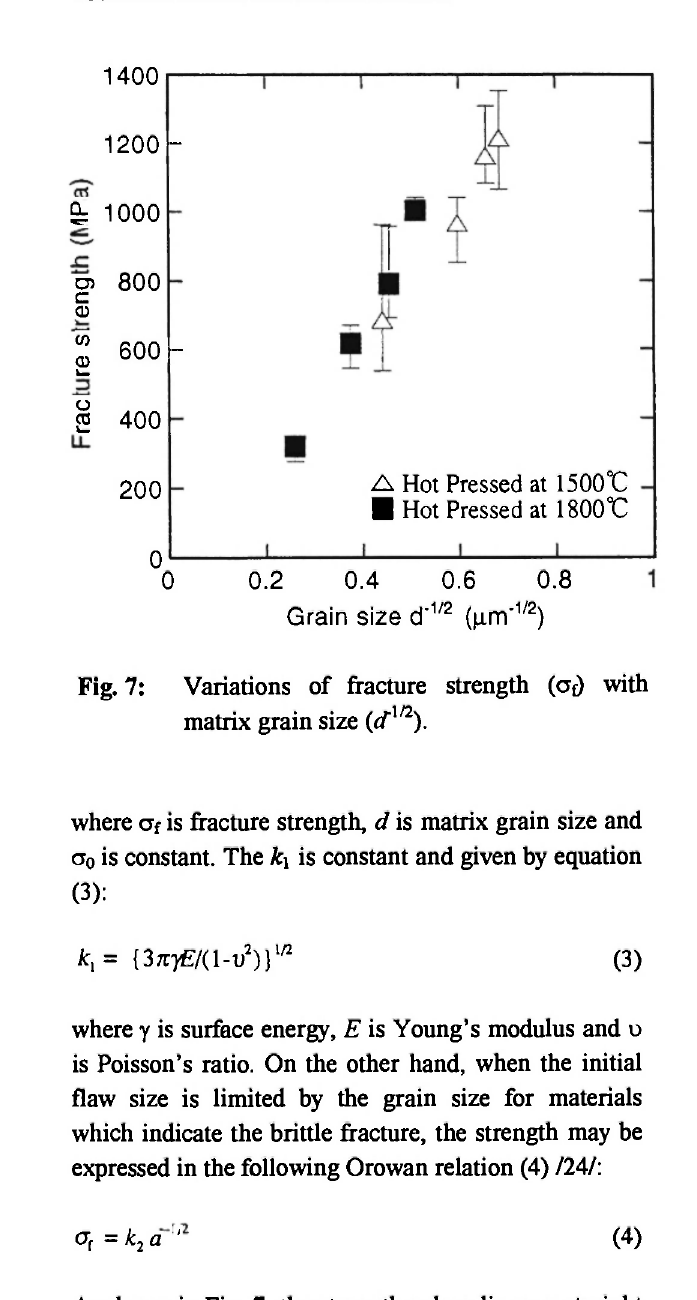
Fig. 8: Variations of shear modulus and internal friction with temperature for MoSi SiC